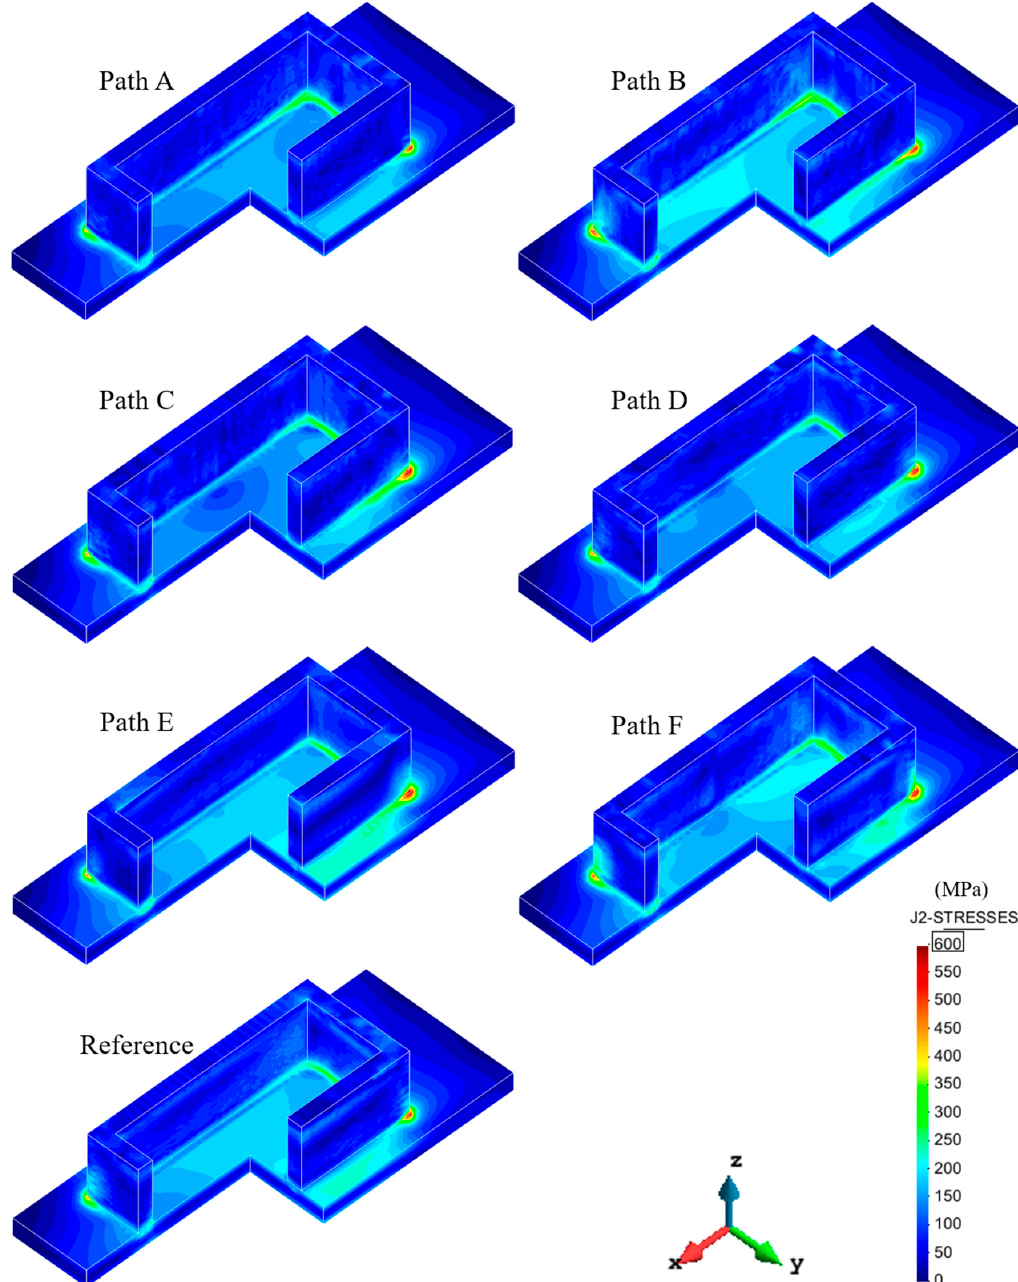
Figure 16. Comparison of residual von Mises stress field under Case 1 for different building strategies.